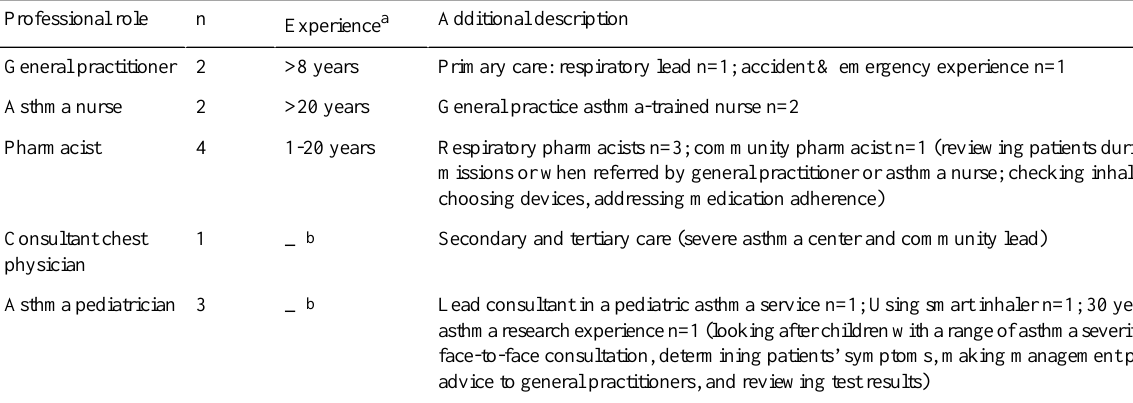
Table 3. Characteristics of professional participants.